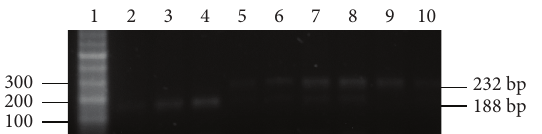
Figure 1: Electrophoresis of PCR products in patients and controls. The polymorphic fragments A/A resulted in a 232 bp band, the G/G fragment resulted in a 188 bp band, and the A/G variation resulted in a doublet of the 188 bp and 232 bp bands on a 2% agarose gel.